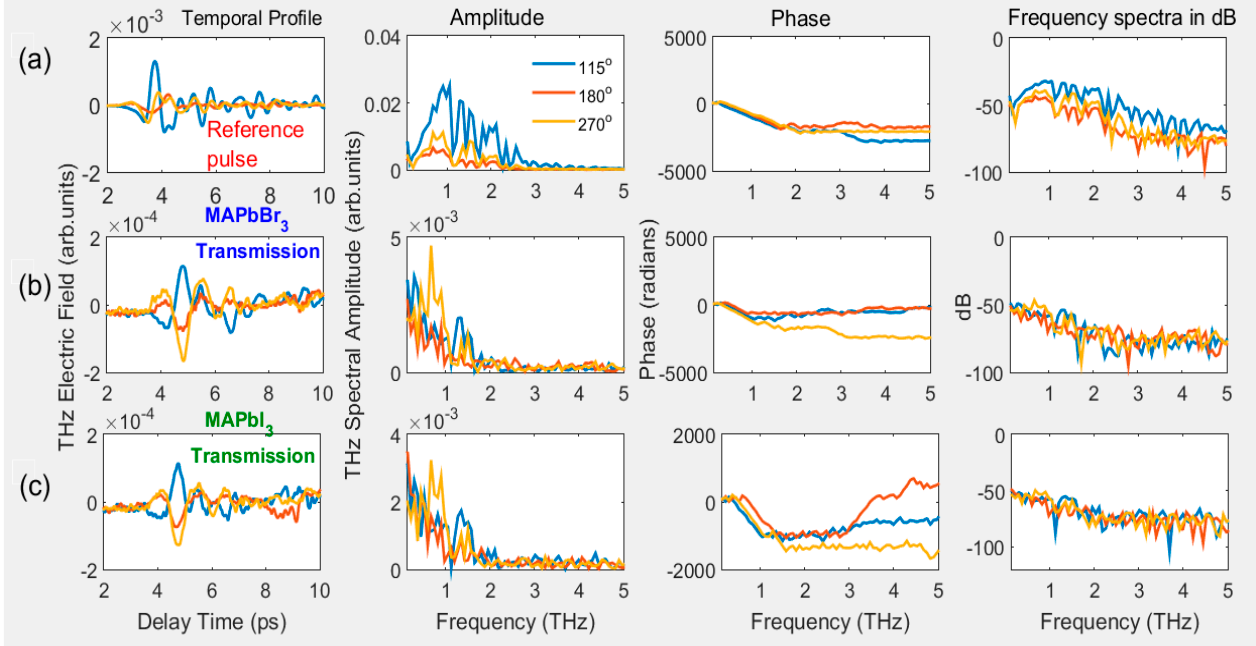
Figure 4. Generated THz pulse temporal profile, amplitude, phase, and frequency spectra ( a ) at rotational angles of BBO 115°, 180°, and 270° (measured between 0-360°, with 5° interval but presented only at three angles). THz transmission from ( b ) MAPbBr 3 and ( c ) MAPbI 3 PSCs using refence THz pulses from ( a ). The PSCs kept at the focus position of THz pulses from PM 2 .